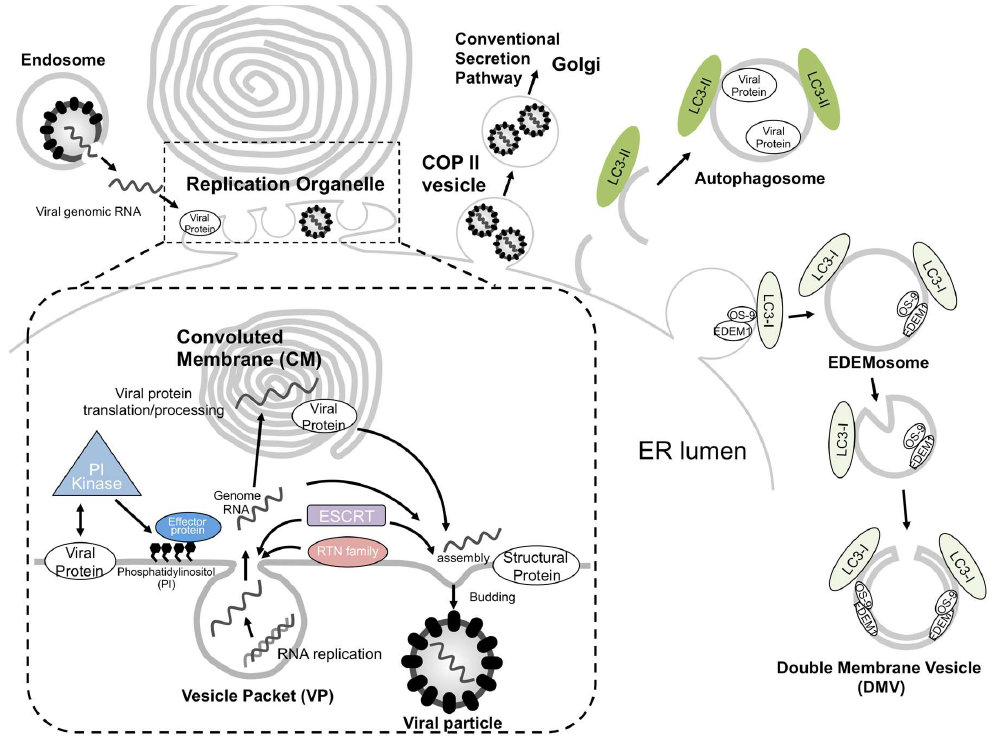
Figure 2. Schematic model of single-stranded positive-sense RNA viruses (ssRNA( + )) virus replication organelle biogenesis in the endoplasmic reticulum. After entry of the virus via the endocytosis pathway, its positive-stranded RNA genome is released into the cytoplasm by membrane fusion. Viral non-structural proteins are directly or indirectly interacted with lipid modifiers, which deform the endoplasmic reticulum (ER) membranes to create vesicle packets (VPs) for the replication of their genomic RNA. Newly synthesized ssRNA( + ) is transported outside the VP to be used as a template for further viral protein synthesis or, alternatively, to the site of progeny virus particle assembly. The site of virus particle assembly is generally close to a VP pore. Reticulon (RTN) family proteins are involved in VP formation, and endosomal sorting complex required for transport (ESCRT) proteins can function in VP or virus particle formation. Progeny virus particles are sorted into coat protein complex II (COP II) vesicles and released via the conventional secretion pathway. Apart from this pathway, autophagosomes or EDEMosomes have been proposed to be involved in the formation of the ssRNA( + ) virus replication compartment.